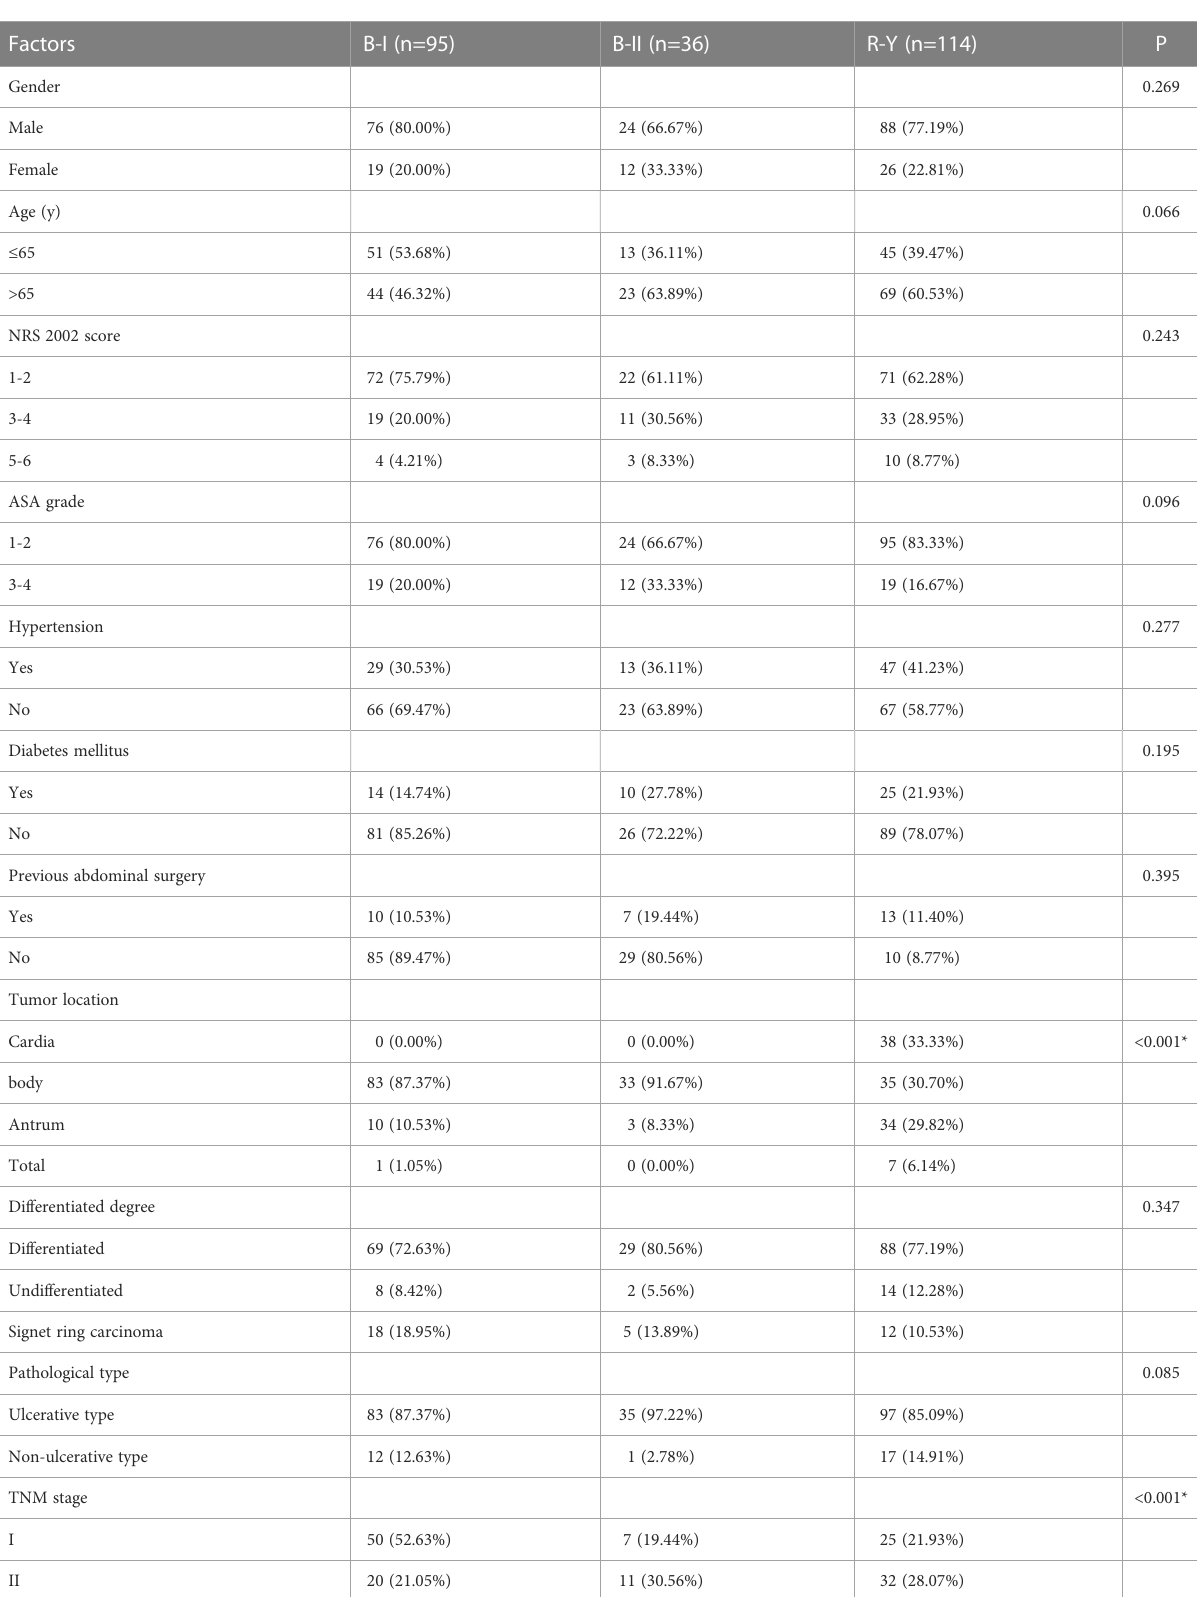
TABLE 1 Patient baseline